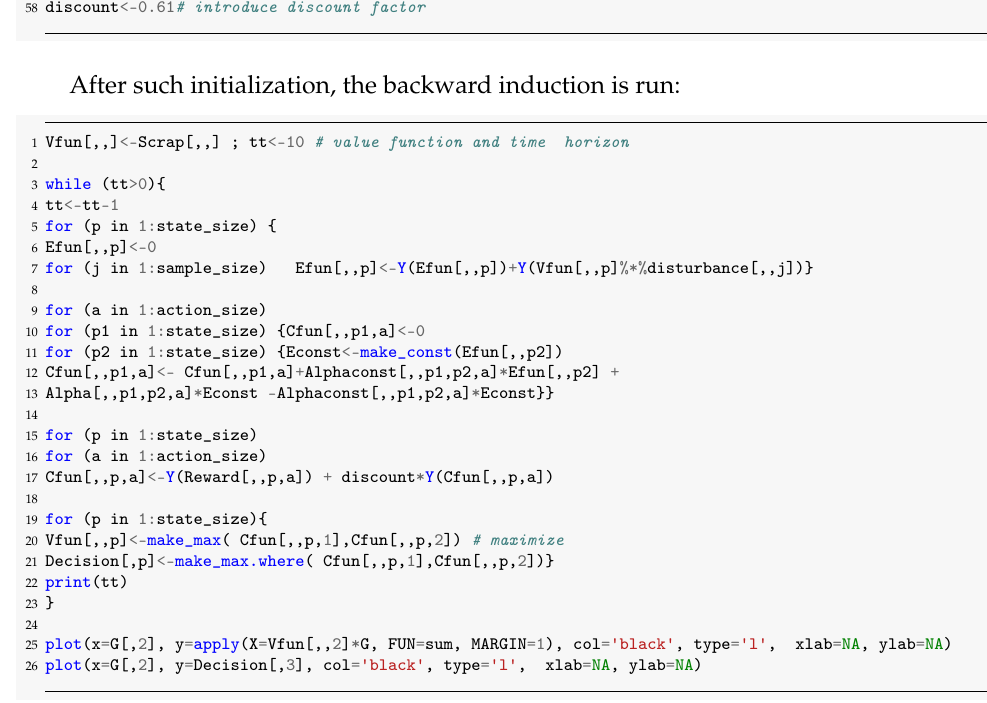
The Figure 3 depicts the value function for the state p = 2 depending on the believe state, such that the x - axes is interpreted as the conditioned probability that the system is in the deterministic growth regime. That is, the end points of the graph represent values of the expected return of the optimal strategy under the condition that it is known with certainty that the system starts in random growth (left end) or in deterministic growth (right end). Observe that those values are close to 2660.412 and 3012.010 obtained in the classical Markov decision setting. Naturally, the uncertainty about the current regime yields intermediate values, connected by a convex line.